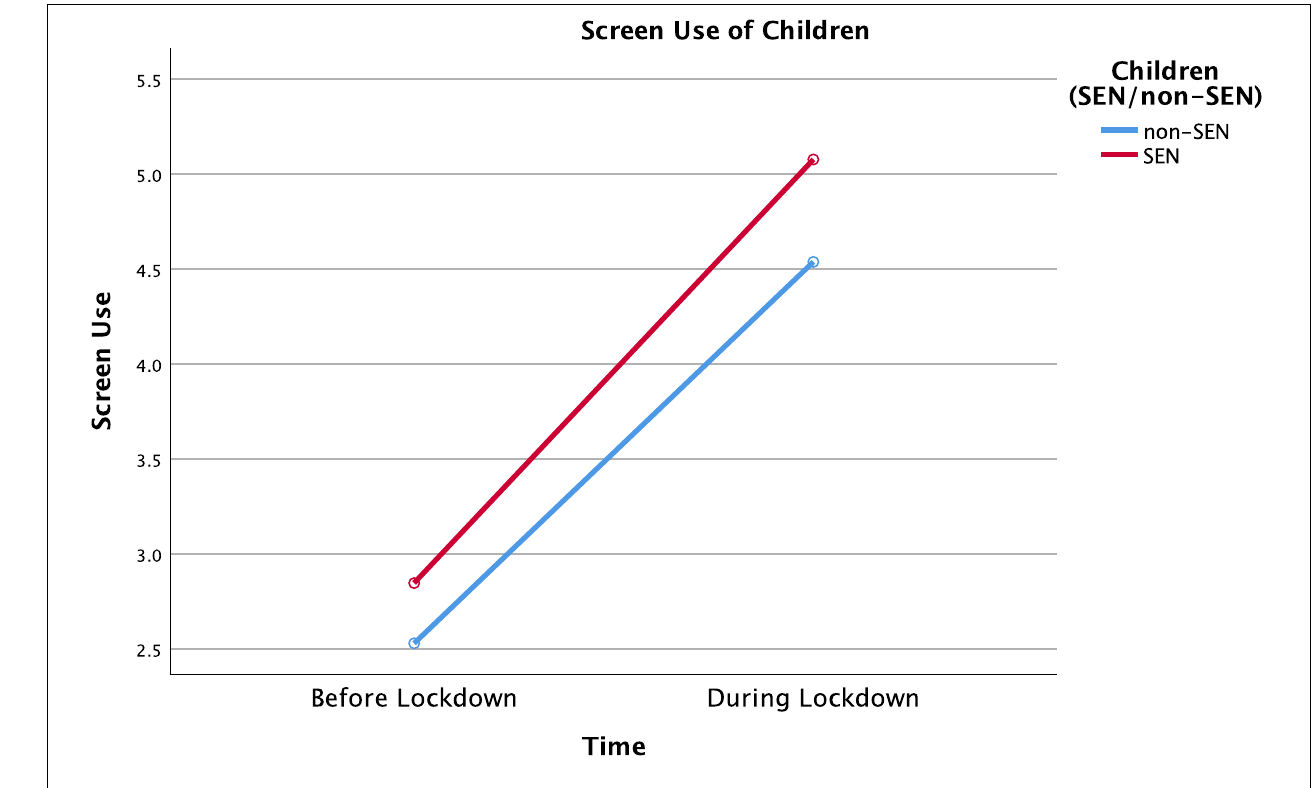
FIGURE 1 | Change in children’s screen